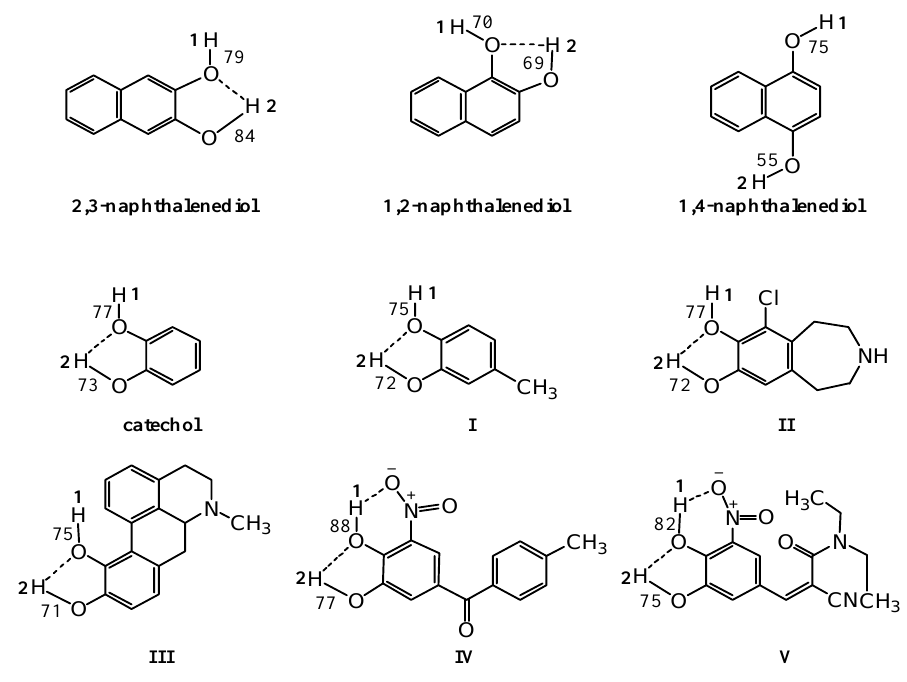
Figure 2. O-H BDEs (in kcal/mol) of catechol and five types ( I - V ) of catecholic drugs, corresponding to donate first (labeled as 1) and second (labeled as 2)